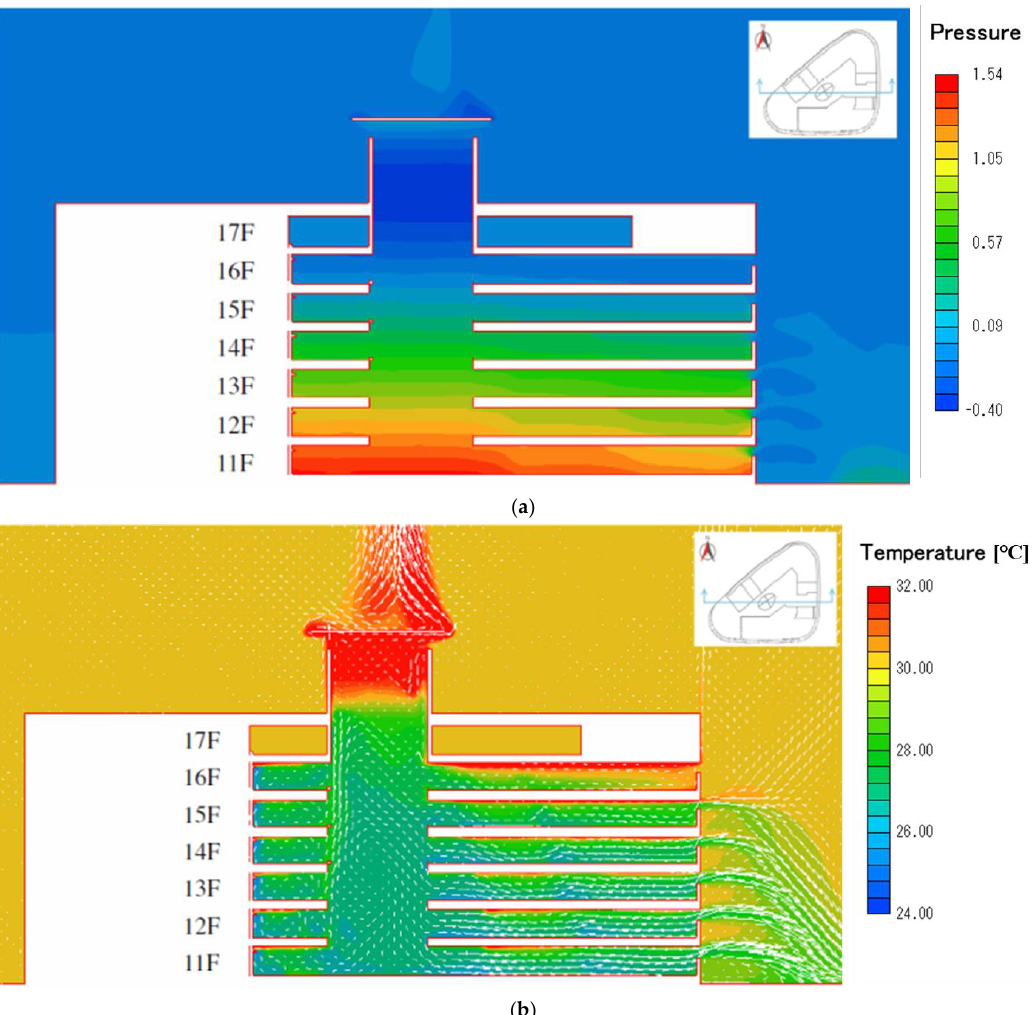
Figure 13. Simulation at 30 °C when both external air and cold air from office rooms are applied. ( a ) Pressure distribution. ( b ) Temperature contour with flow vectors.